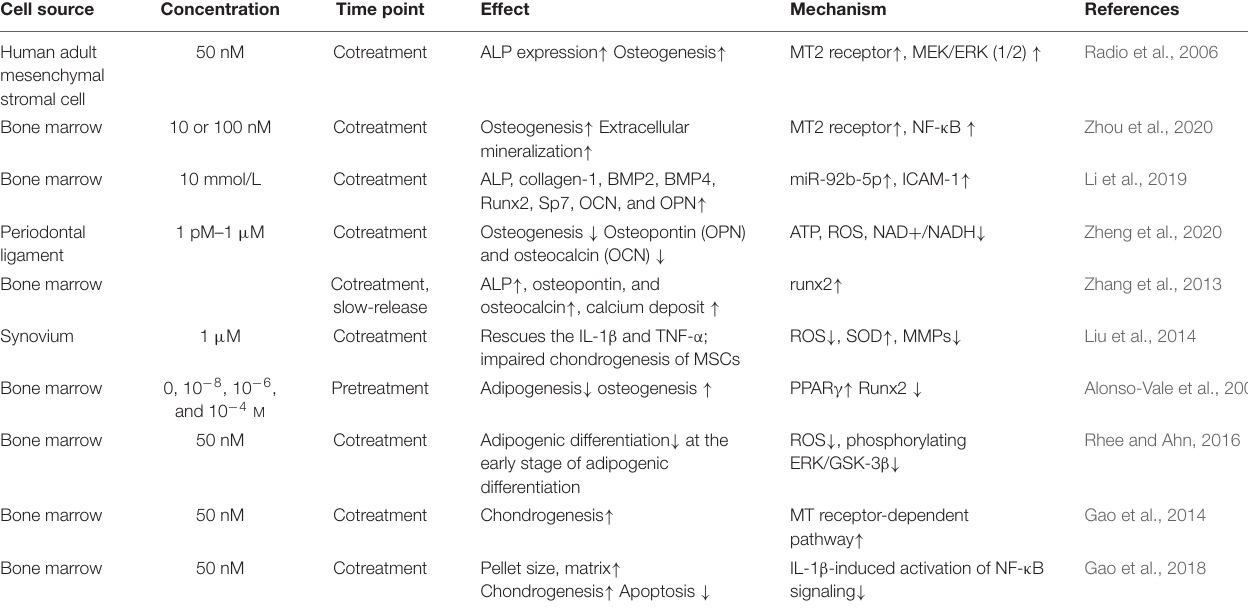
TABLE 1 | Melatonin mediates in mesenchymal stromal cell (MSC) osteogenesis, chondrogenesis, and adipogenesis.